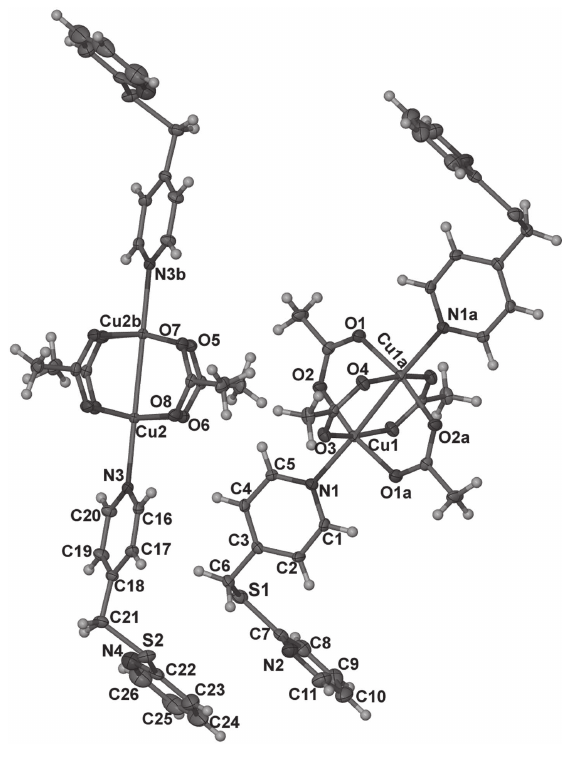
Table 1: Data collection and handling.